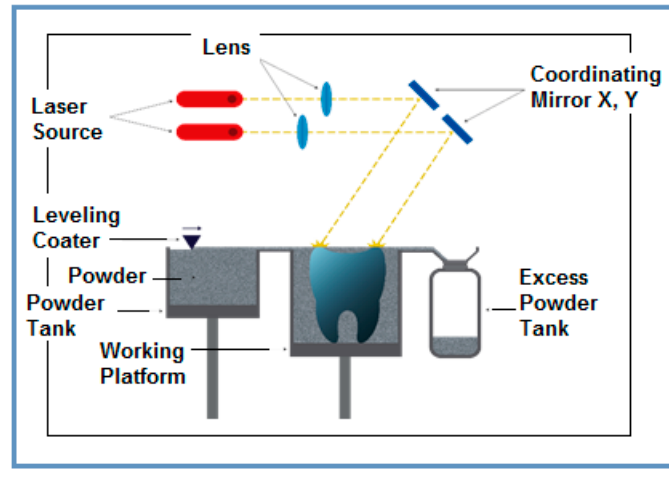
Figure 2. System MySint100 Dual Laser for additive manufacturing. Table 1. The applied L-PBF processing